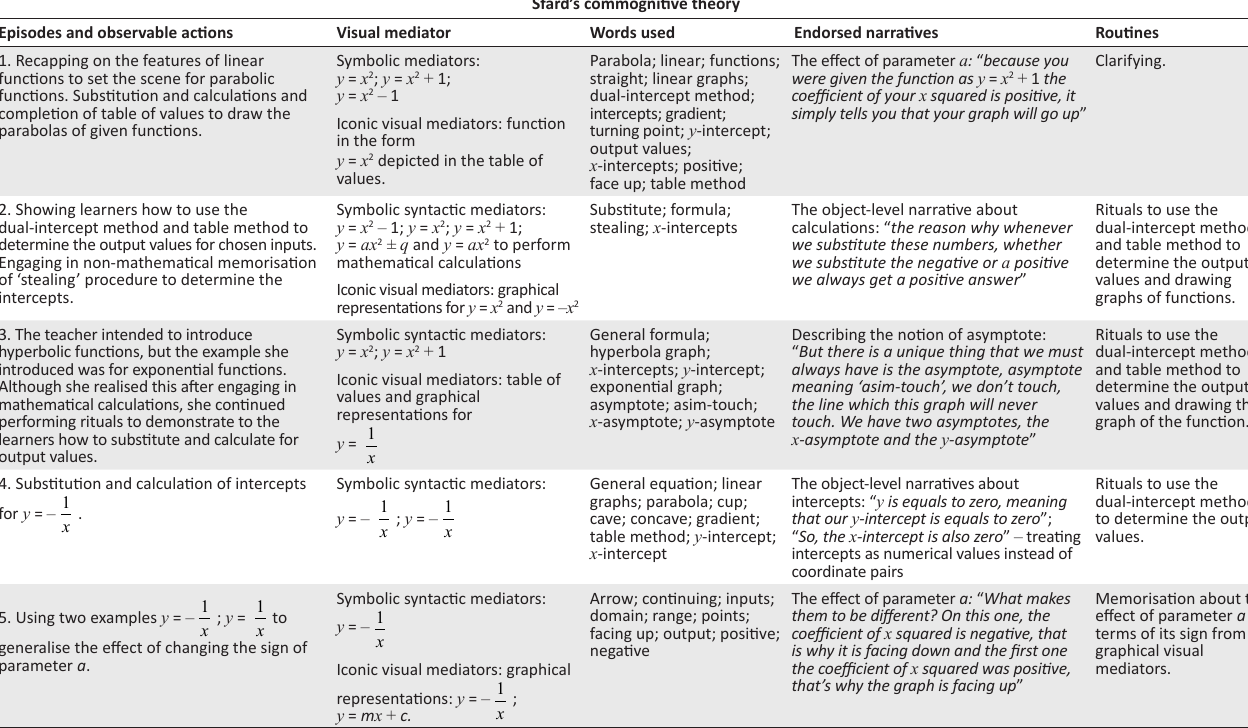
TABLE 4: Discourses in Tinyiko’s teaching